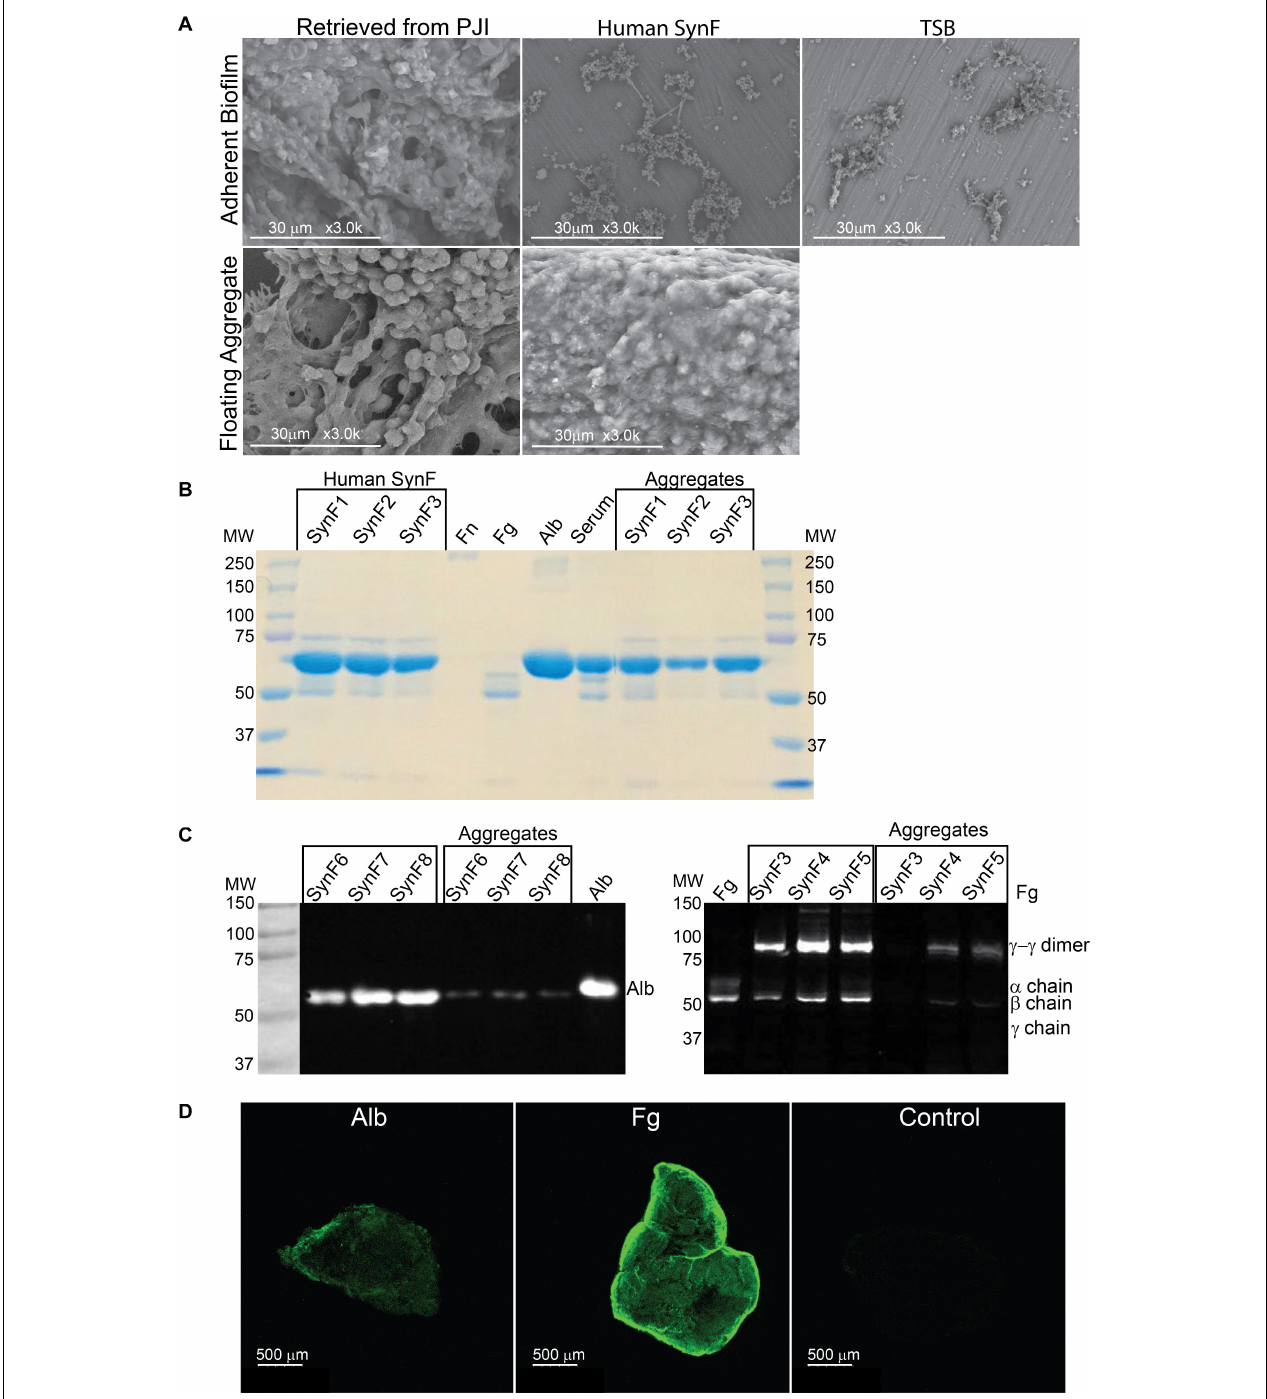
FIGURE 1 | Synovial fluid aggregate morphology and composition. (A) (Top) Using SEM, biofilm morphology in samples retrieved from an infected knee replacement [periprosthetic joint infection (PJI)] or formed on titanium using methicillin-susceptible Staphylococcus aureus (MSSA) in human synovial fluid (SynF) or Trypticase Soy Broth (TSB). (Bottom) Floating aggregates retrieved from an infected knee replacement or floating aggregates formed with MSSA in human synovial fluid. (B) Sodium dodecyl sulfate–polyacrylamide gel electrophoresis (SDS-PAGE) gel stained with Coomassie Blue. The gel shows the composition of human synovial fluid and of synovial fluid MSSA aggregates from three separate samples of synovial fluid, as compared to fibronectin (Fn), fibrinogen (Fg), albumin (Alb), and serum controls. (C) Western blot analysis of MSSA aggregates from synovial fluid for Alb (left) and for Fg (right) . The γ − γ dimer and α chain are indicated, as compared with human synovial fluid, Fg, and Alb standards. Lanes represent human synovial fluid samples and resulting aggregates from different samples. (D) MSSA aggregates stained for Alb, Fg, or secondary antibody alone (Control). All images are representative images of at least three samples.